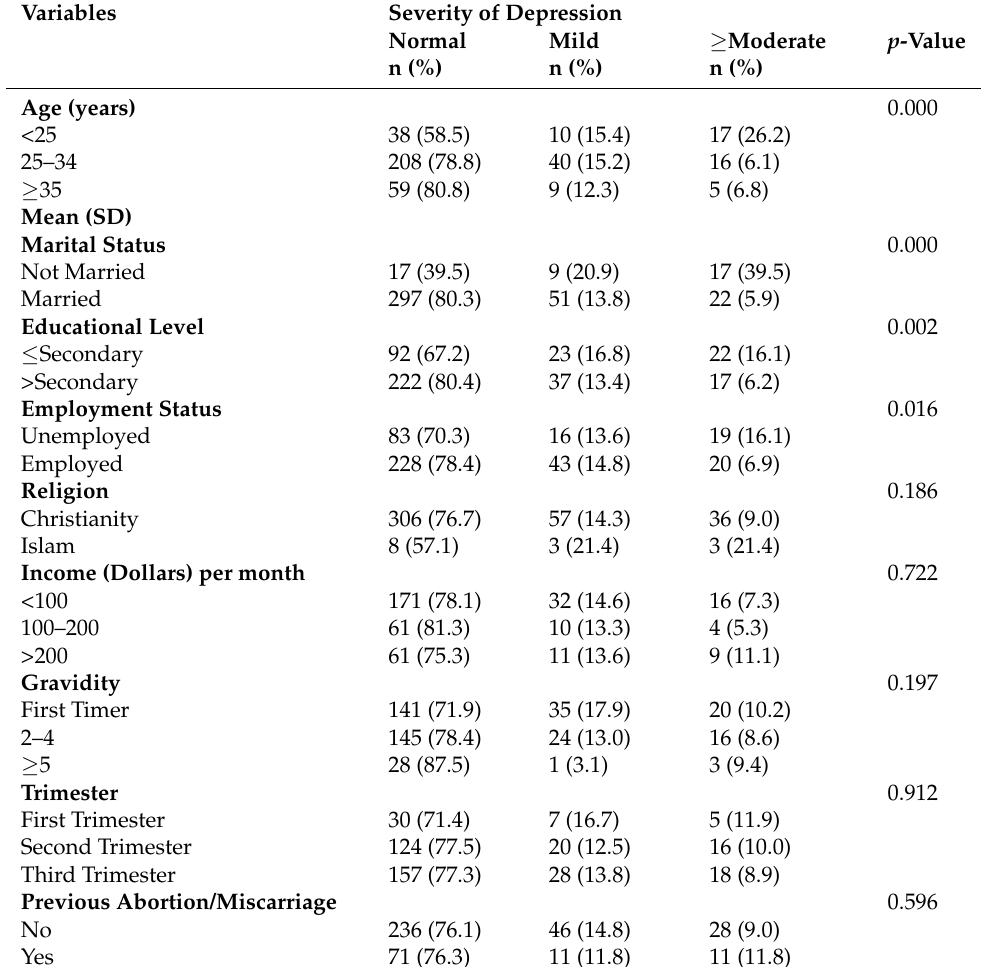
Table 3. Associations between the respondents’ characteristics and